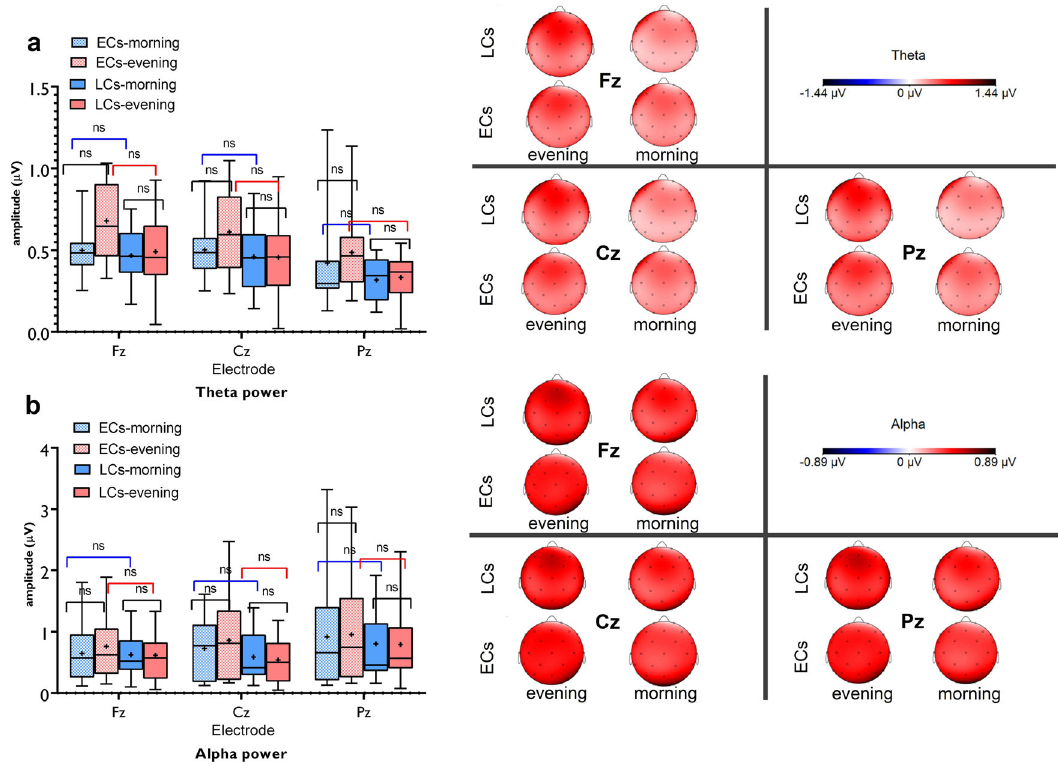
Fig. 6 Resting-EEG theta and alpha oscillations at the circadian-preferred and non-preferred time for ECs and LCs. a The results of 3 (Fz, Cz, Pz electrodes) × 2 (chronotype) × 2 (daytime) ANOVA showed no signi fi cant interaction of electrode × chronotype × daytime ( F 1.36 = 1.65, P = 0.207) or electrode × chronotype ( F 1.90 = 0.20, P = 0.806) or electrode × daytime ( F 1.36 = 2.17, P = 0.142) on theta oscillations. The interaction of chronotype × daytime was marginally signi fi cant ( F 1 = 4.65, P = 0.040). Post hoc comparisons showed no signi fi cant difference of theta oscillations between groups in the morning ( t Fz = 0.36, P > 0.999; t Cz = 0.53, P > 0.999; t Pz = 1.22, P > 0.999) and evening ( t Fz = 2.42, P = 0.097; t Cz = 1.88, P = 0.371; t Pz = 1.86, P = 0.382). b For alpha oscillations, no signi fi cant interaction of electrode × chronotype × daytime ( F 1.14 = 0.30, P = 0.627) or electrode × chronotype ( F 1.36 = 1.17, P = 0.302), electrode × daytime ( F 1.14 = 0.35, P = 0.615) or chronotype × daytime ( F 1 = 1.68, P = 0.204) were found. Pairwise comparisons are calculated by post hoc t tests (paired, two-sided, P < 0.05). n = 30 (15 ECs, 15 LCs; data of one participant in each group are excluded due to noise). Data are presented as mean values ± SEM. The horizontal bar shows the median, the + shows the mean, the upper and lower boundaries show the 25th and 75th percentiles, respectively and the whiskers show the 5 – 95 percentile. ECs early chronotypes, LCs late chronotypes, ns nonsigni fi cant, µ V microvolt. [*] indicates a signi fi cant